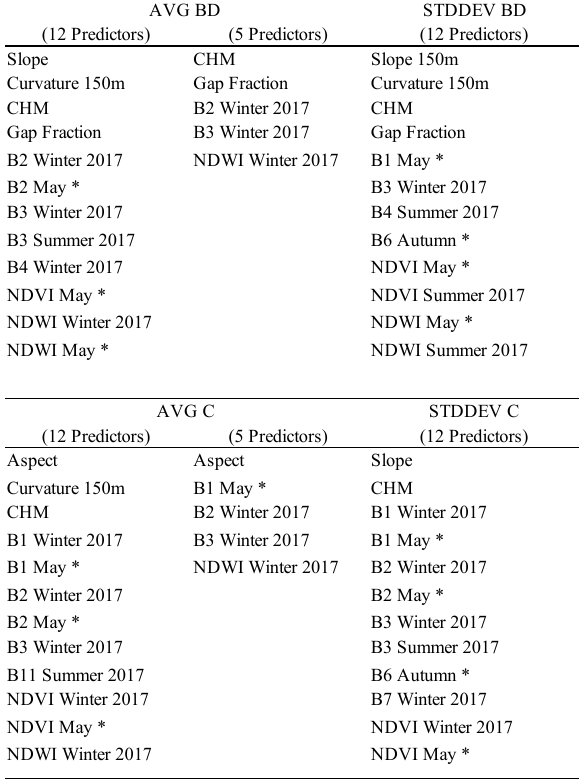
Table 1. Reduced sets of predictors utilized for the RF